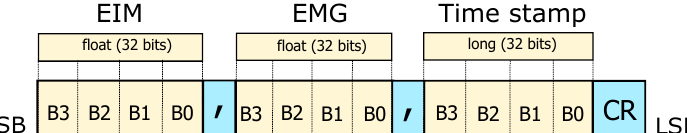
Figure 8. Package structure for RF